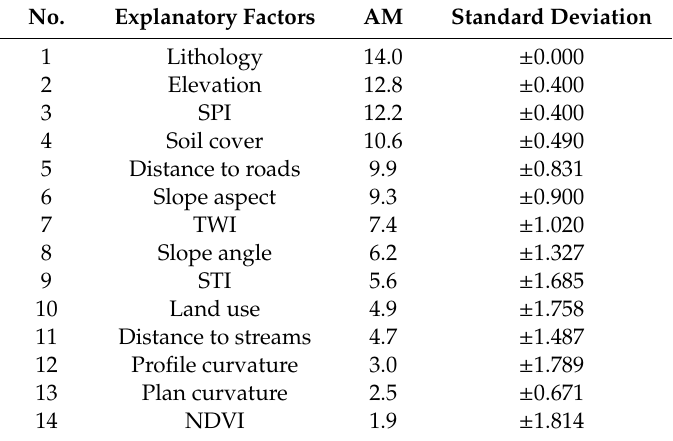
Table 2. Predictive capabilities of spring explanatory factors using the LSVM algorithm. AM: average merit.